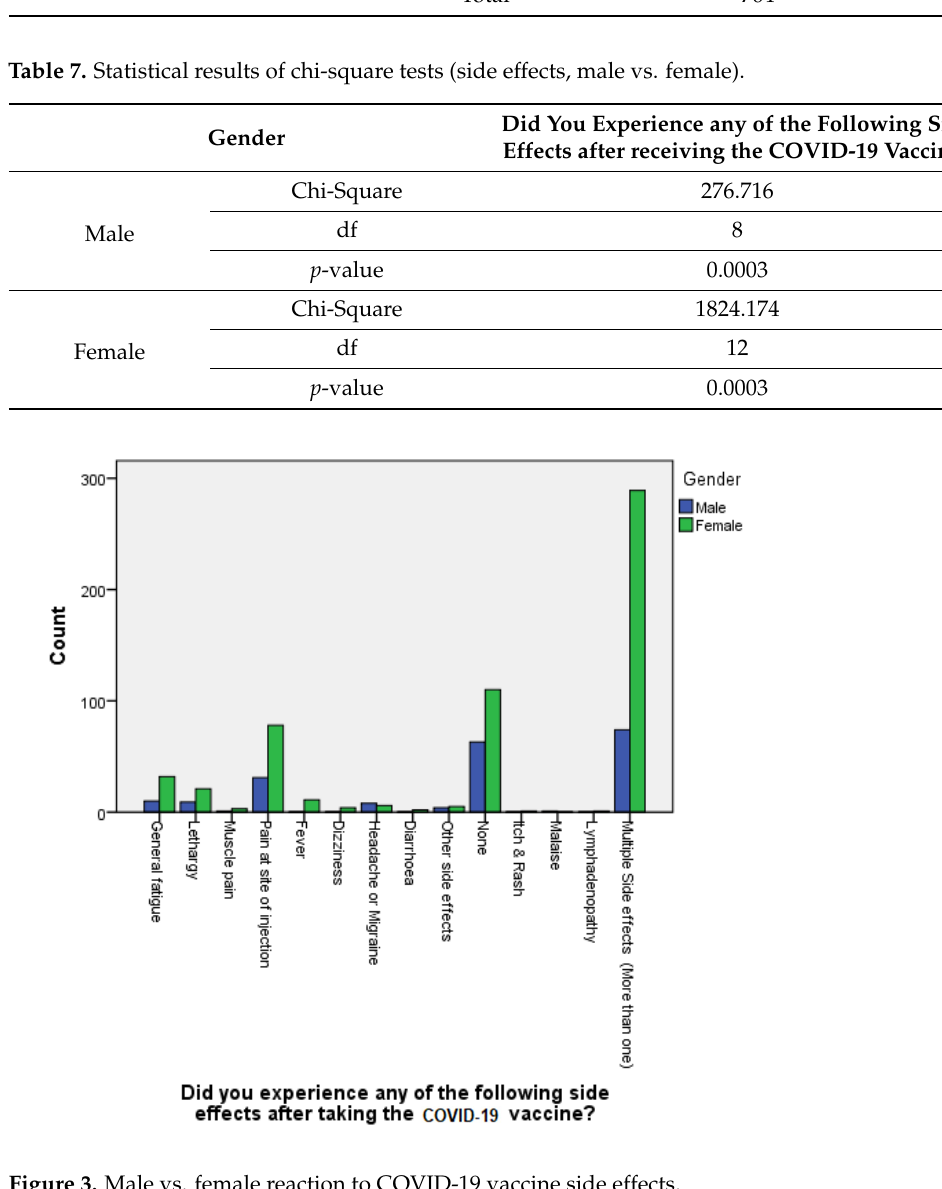
Figure 3. Male vs. female reaction to COVID-19 vaccine side effects.